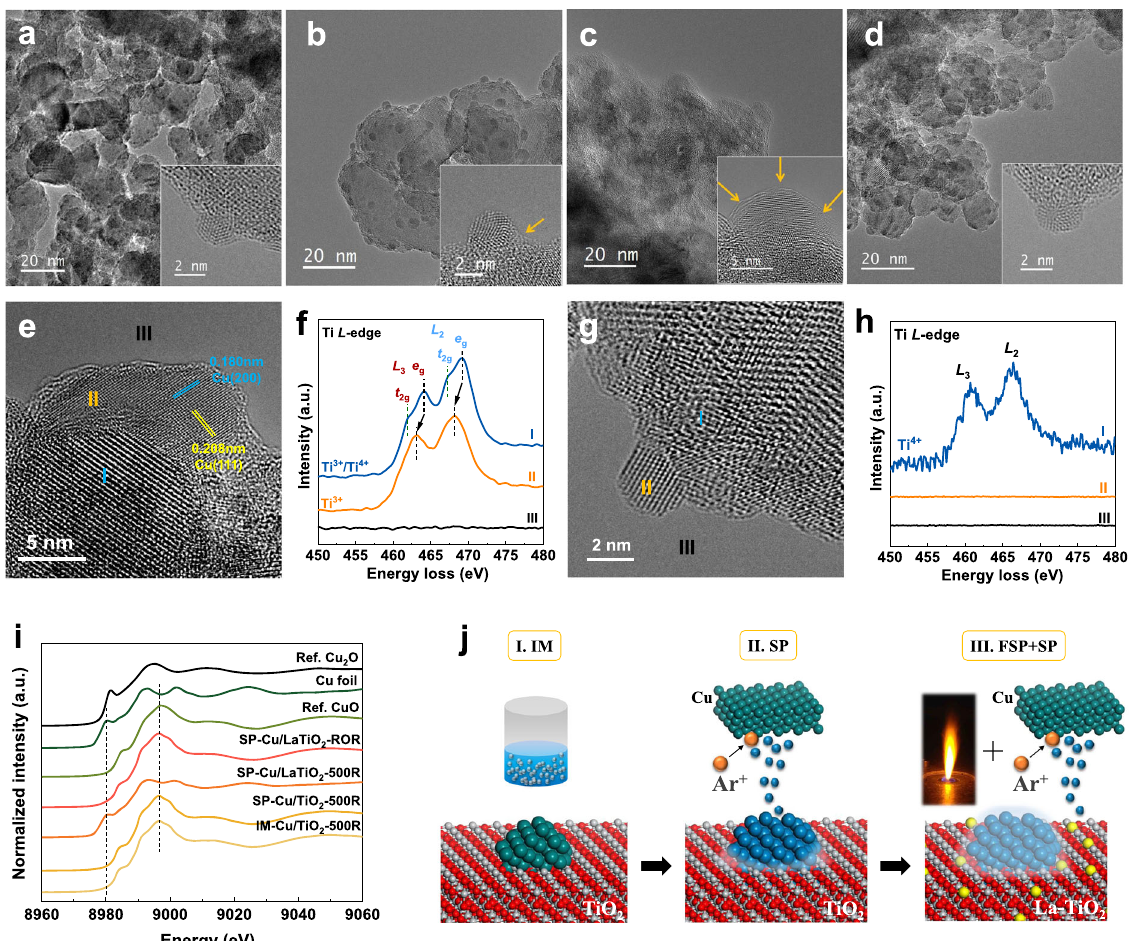
Fig. 1 Identi fi cation and reversibility of encapsulation. a – d Aberration-corrected HRTEM images of a IM-Cu/TiO 2 -500R, b SP-Cu/TiO 2 -500R, c SP-Cu/ LaTiO 2 -500R, and d SP-Cu/LaTiO 2 -ROR (500R-400O-250R). Insets are the magni fi cation of a single Cu nanoparticle, where the orange arrows highlight the oxide overlayer. e – h Aberration-corrected HRTEM images ( e , g ) and EELS spectra ( f , h ) over SP-Cu/LaTiO 2 -500R ( e , f ) and SP-Cu/LaTiO 2 -ROR ( g , h ) catalysts. i Cu K-edge X-ray absorption near edge structure (XANES) of different samples, Cu foil, reference Cu 2 O and reference CuO. j Schematic of the development progress of the Cu/TiO 2 catalysts in promoting encapsulation, where green, blue, and yellow balls represent normal Cu atoms, sputtered Cu atoms, and La atoms,